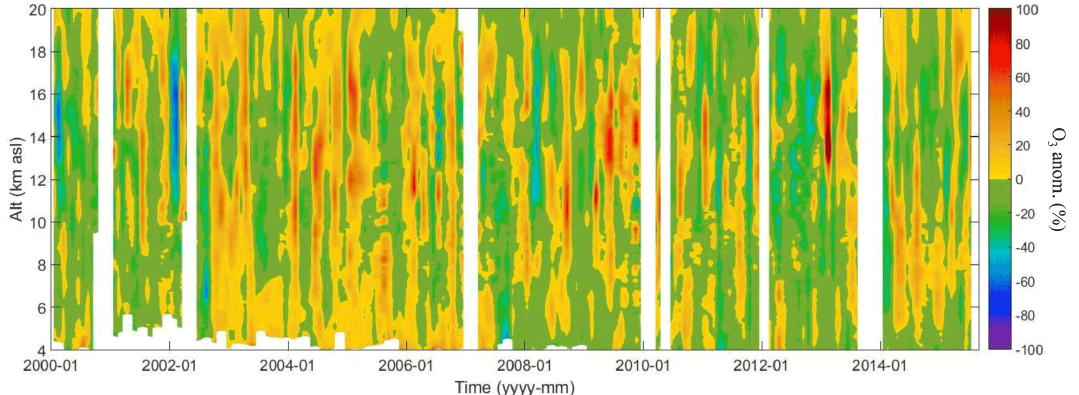
Figure 5. De-seasonalized ozone mixing ratio above TMF. Anomalies (in %) were computed with respect to the climatological (2000–2015) monthly means.